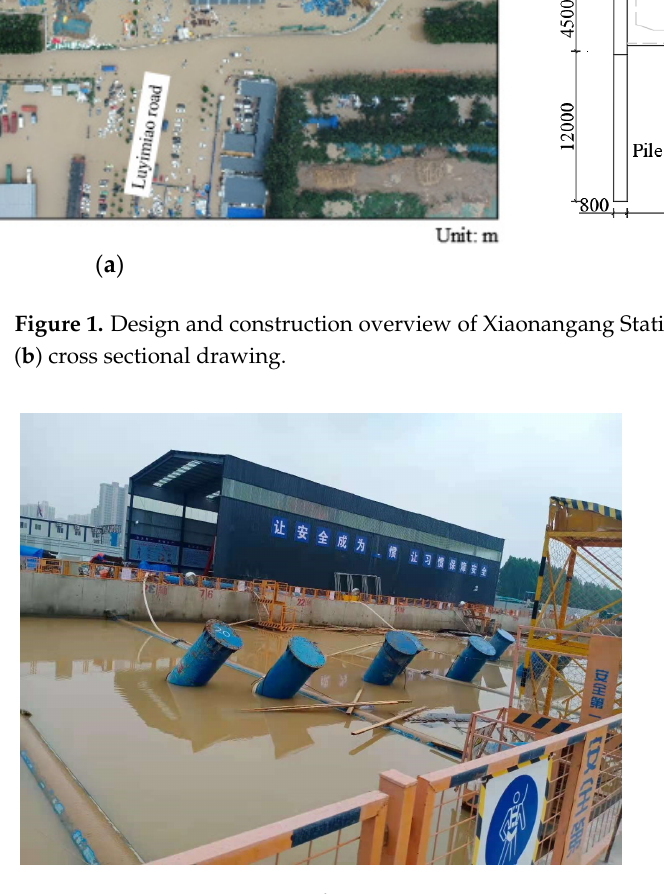
Figure 2. Disaster scene map of Xiaonangang Station.